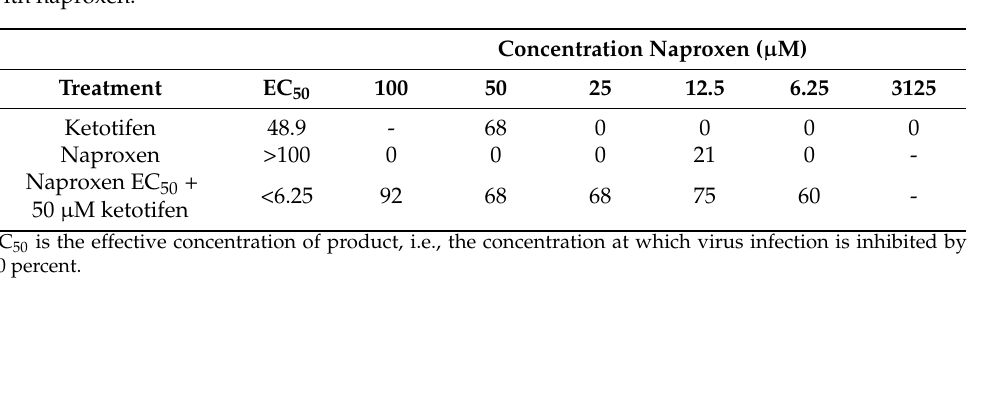
Table 2. EC 50 and percentage inhibition of SARS-CoV-2: 50 µ M ketotifen EC 50 in combination with